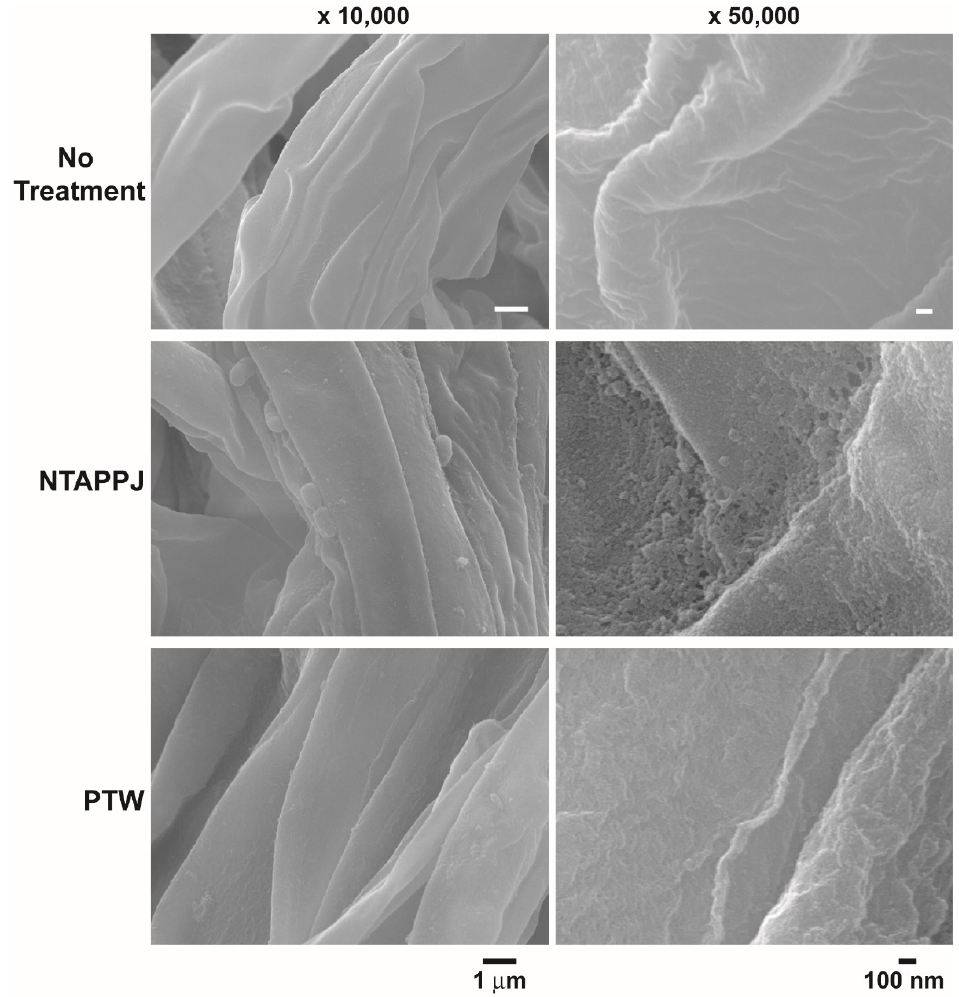
Foods 2021 , 10 , x FOR PEER REVIEW Figure 5. Ultrastructure of mushroom surface with no treatment, NTAPPJ treatment, and PTW treatment.